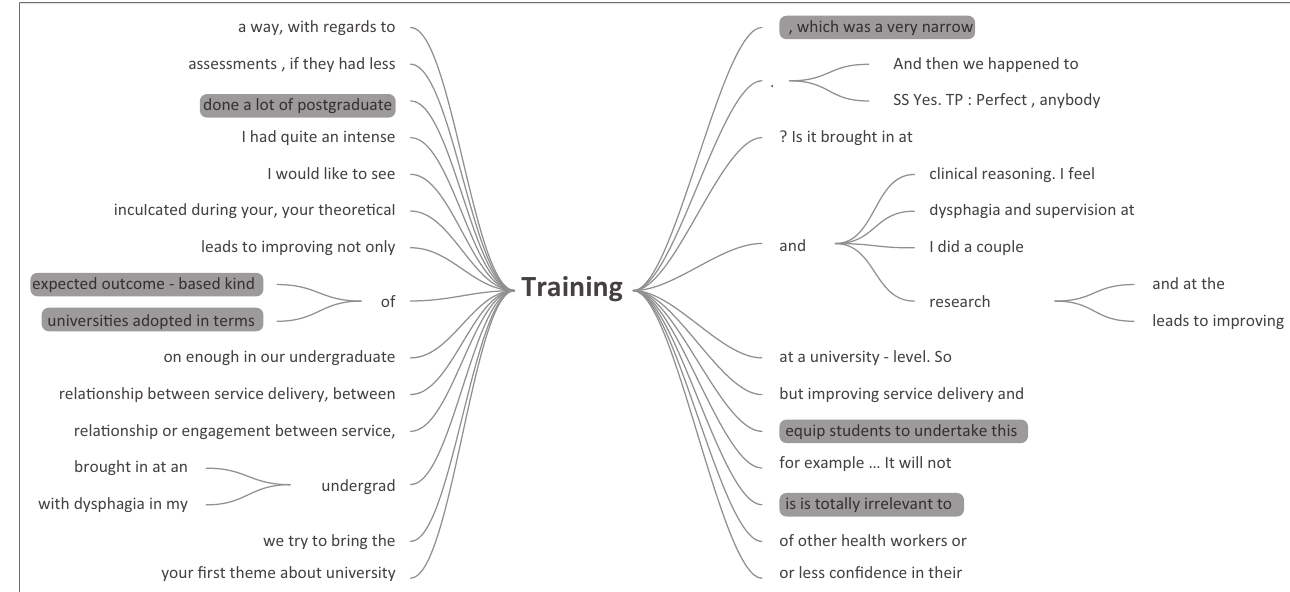
FIGURE 2: Word tree showing the conceptualisation of training in consultation phase by focus group, generated in NVivo 12.